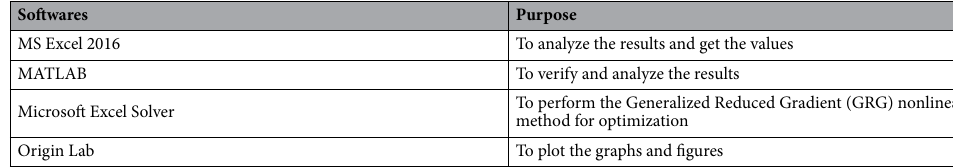
Table 4. Tools used for this study.